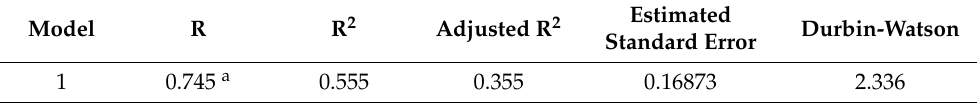
Table 3. Summary of multiple linear regression models of the PSD and proportion of landscape